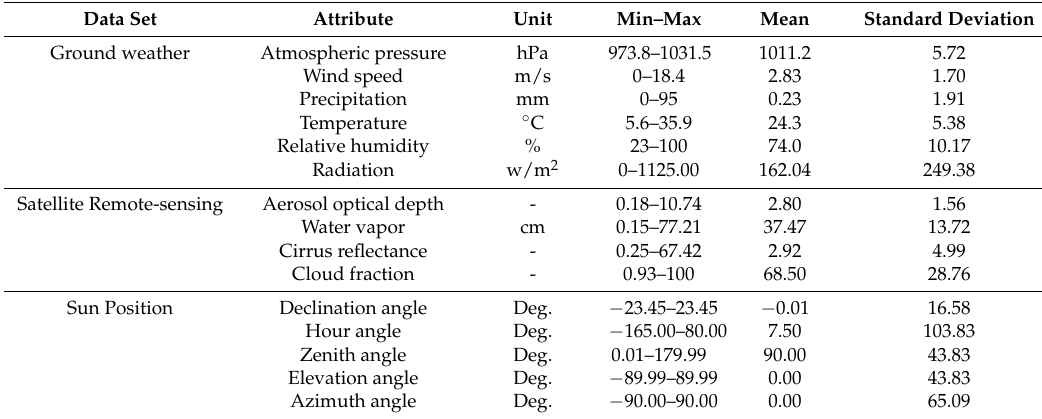
Table 1. Statistics of ground weather data